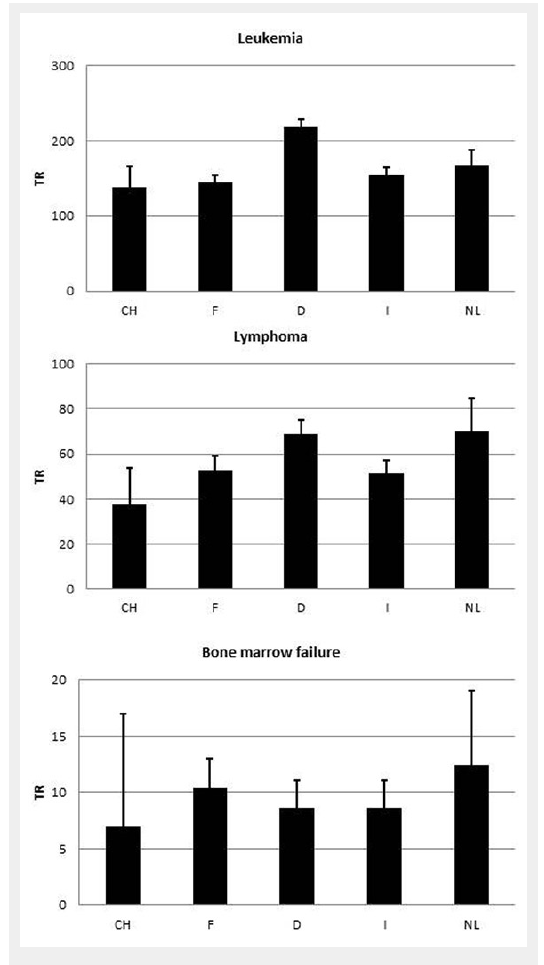
Allogeneic HSCT rates per 10 million inhabitants per year. 1a: leukaemia. 1b: lymphoma. 1c: bone marrow failures syndromes (CH: Switzerland, F: France, D: Germany, I: Italy, NL: the Netherlands).